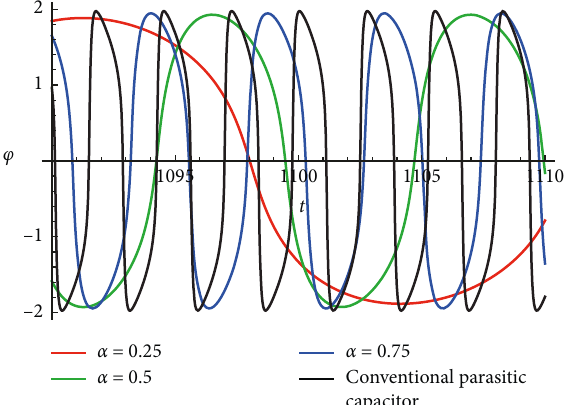
Figure 15: φ vs t of the memristor-inductor circuit with the nonlinear parasitic fractional capacitor/nonlinear conventional parasitic capacitor.